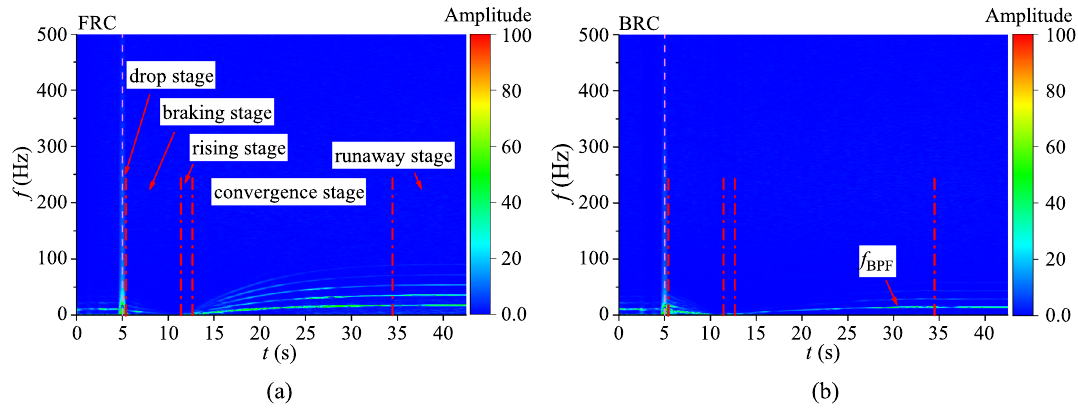
Figure 9. Transient frequency domain diagram of torque fluctuation, ( a ) FRC, ( b ) BRC.